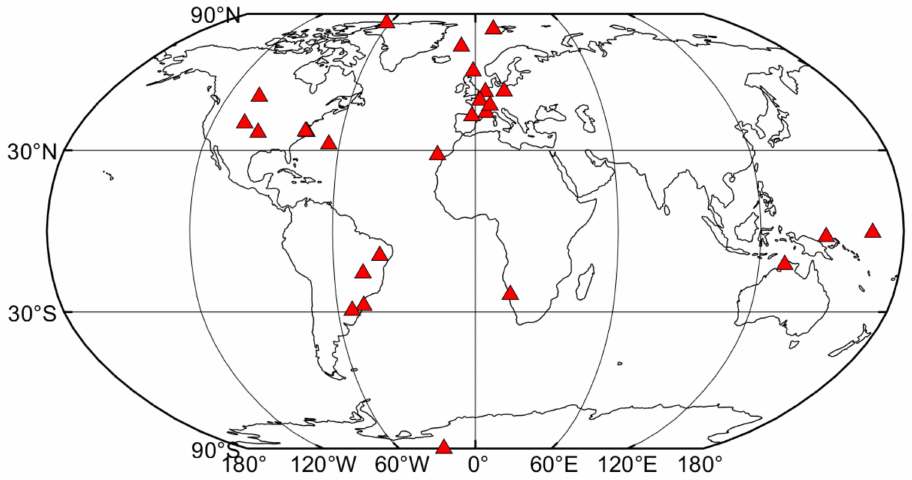
Figure 1. Spatial distribution of the Baseline Surface Radiation Network (BSRN) stations (27 sites represented by red